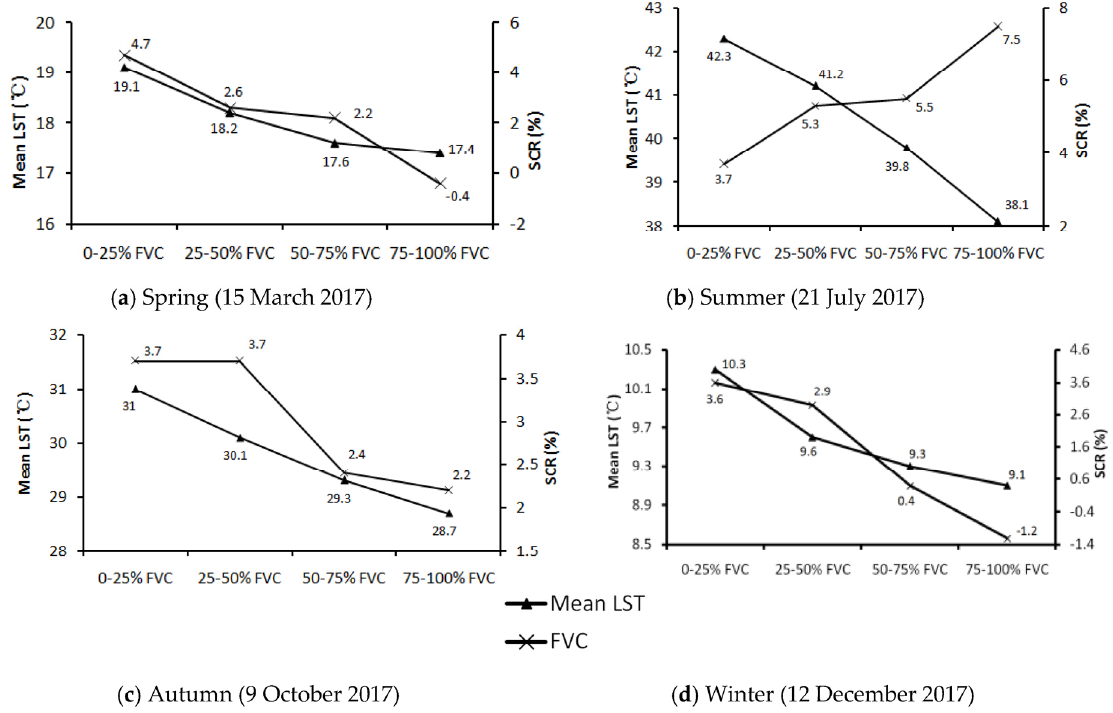
Figure 7. The mean LST and SCR for different percent ISA categories in the four seasons.